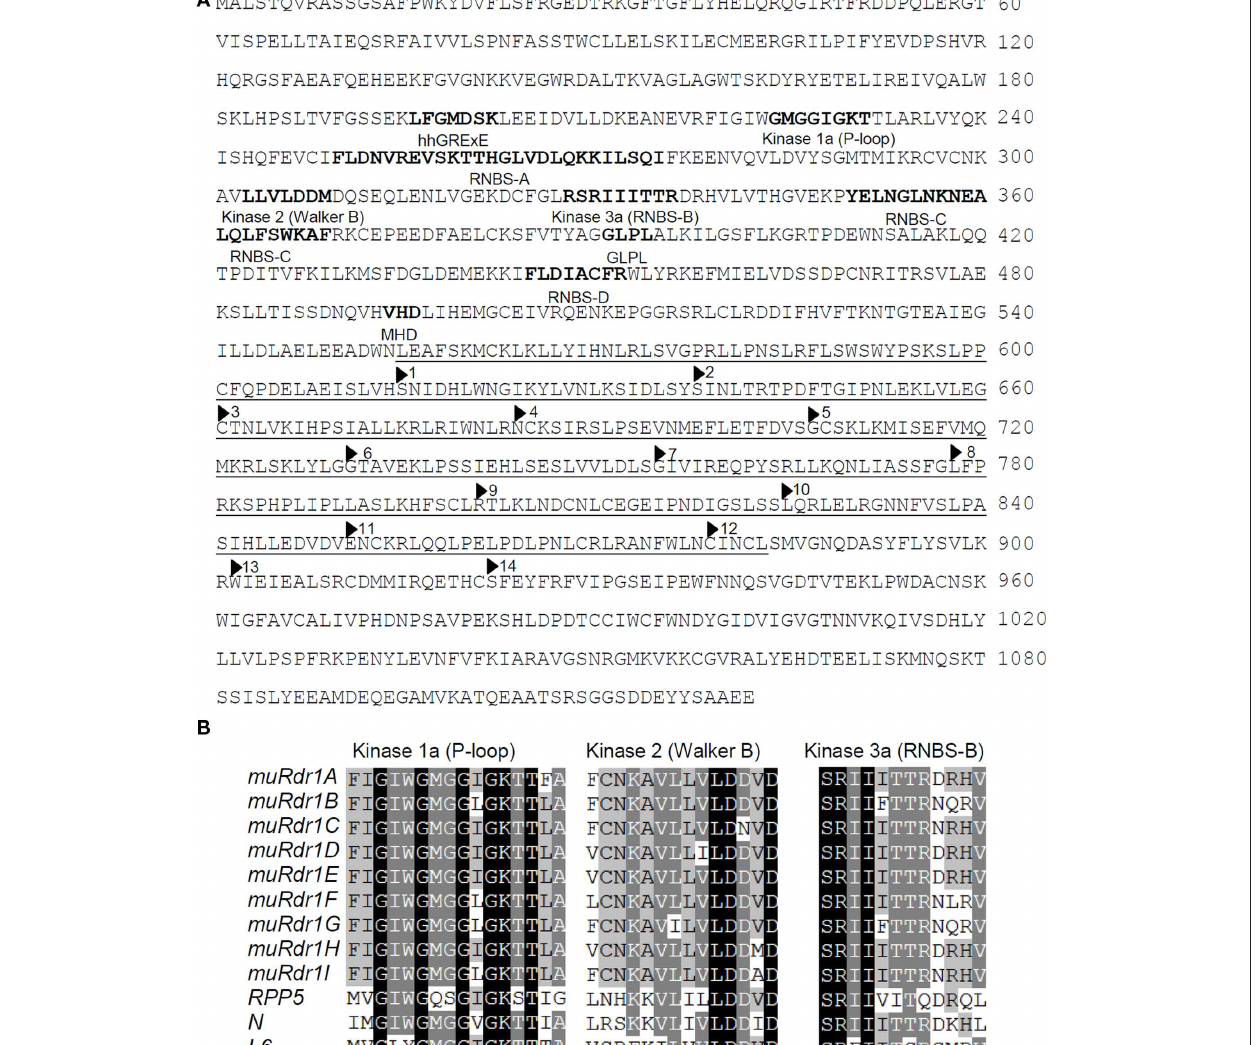
motifs in the conserved region for the nine TNLs and three previously described resistance genes, RPP5 ( Arabidopsis , accession number: AAF08790), N (tobacco, accession number: AAA50763), and L6 (flax, accession